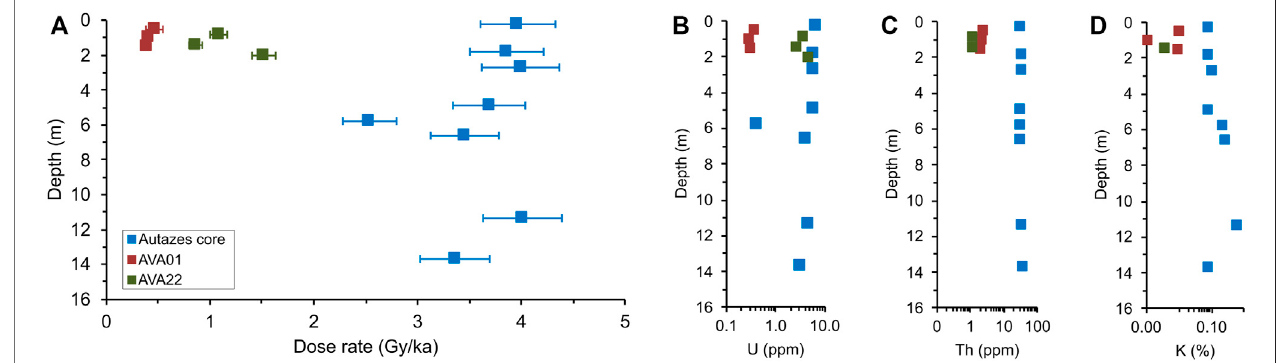
FIGURE 5 | (A) Dose rate, (B) U concentration, (C) Th concentration and (D) K concentration versus depth in sediment pro fi les of the sutdy